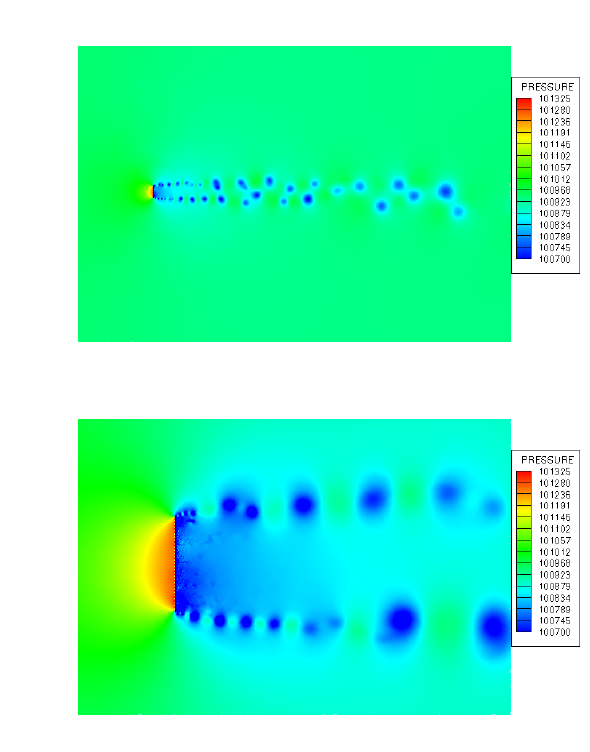
(2019) Fig. 10. The distribution of the pressure for the fence for